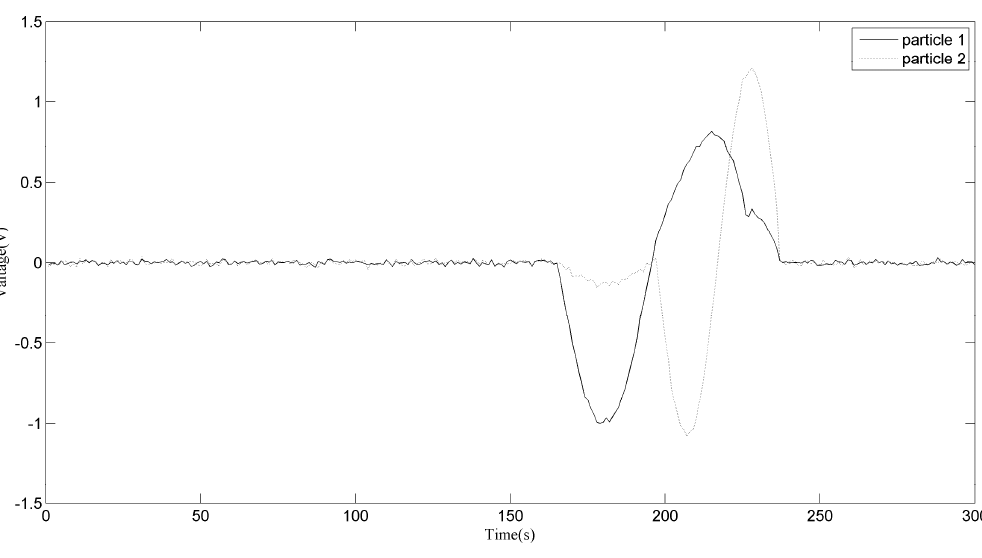
Figure 9. Demixing result of section a1.